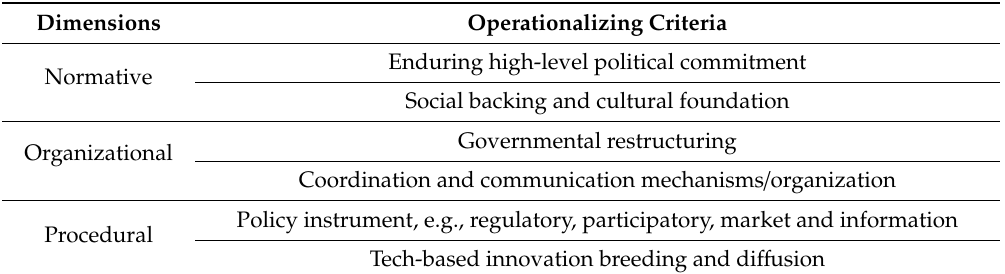
Table 1. Institutional framework adjusted to assess environmental policy integration (EPI) in China’s green energy